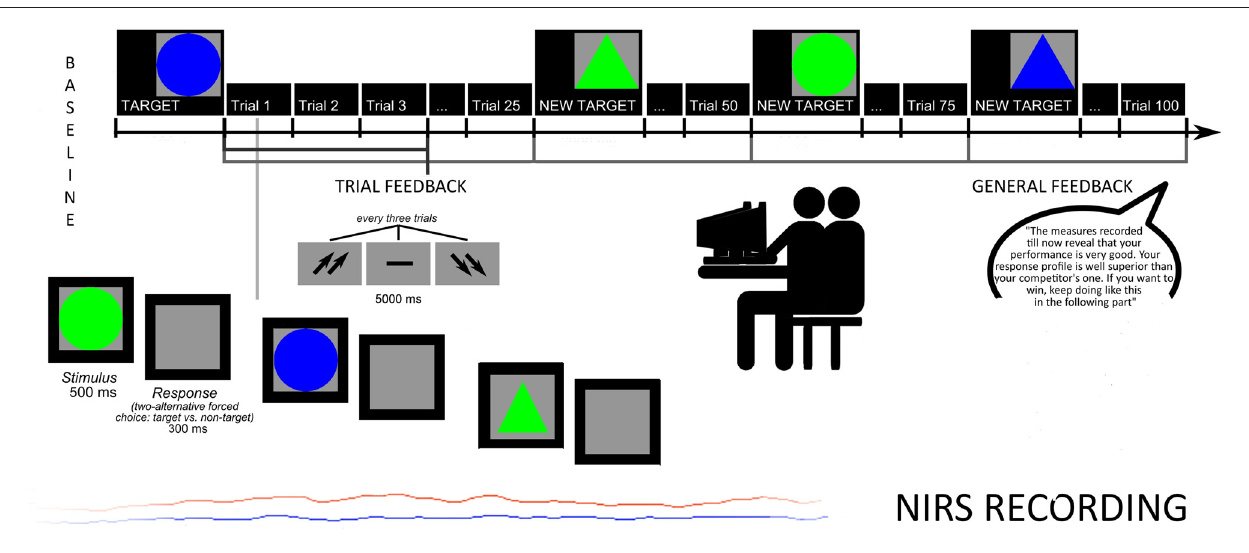
FIGURE 1 | Experimental procedure: task structure and oxyhemoglobin (O2Hb)